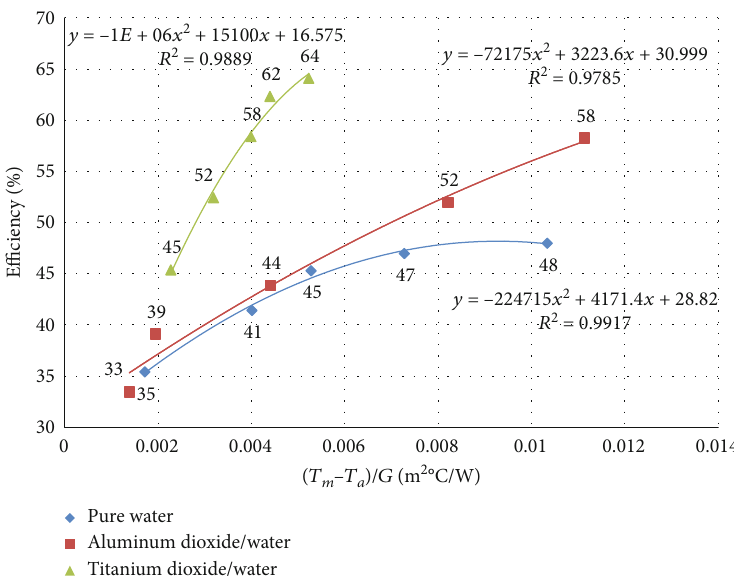
Figure 11: E ffi ciency chart for pure water, Al